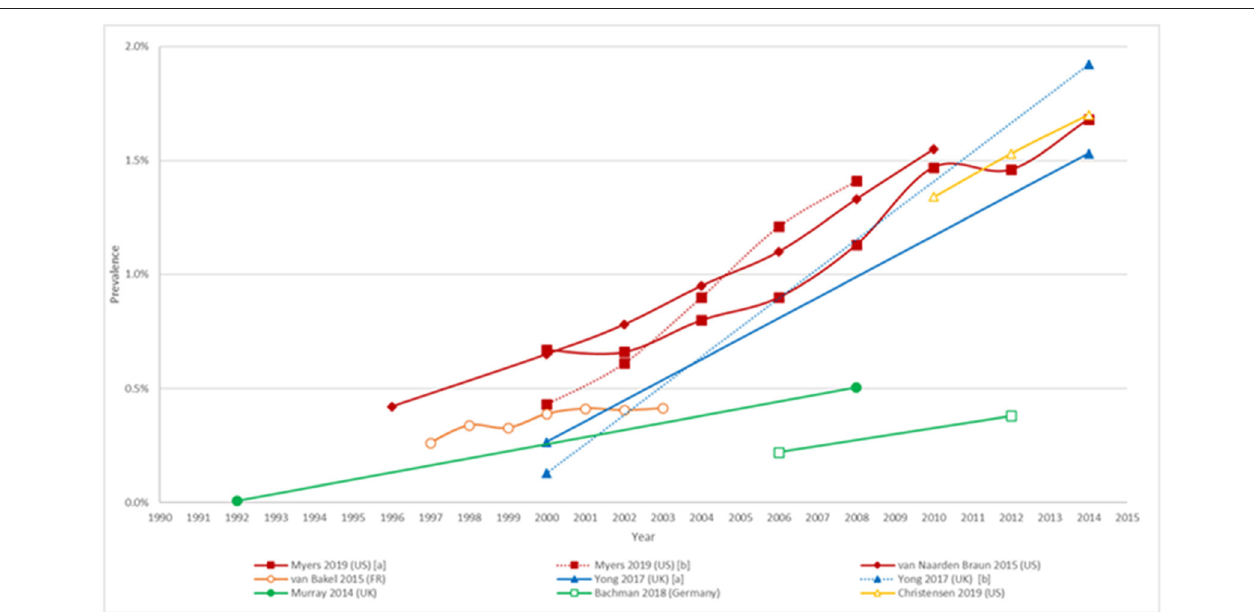
FIGURE 1 | Trends in prevalence of ASD. Myers et al. (21) [a] and [b] include the results from the CDC data set and clinically diagnosed data set, respectively; Yong et al. ( 22) [a] and [b] include results for the age group 5 to 12 and 13 to 17, respectively. Age of the population considered: 4 year-olds: Christensen et al. (15); 7 year-olds: van Bakel (23); 8 year-olds: Myers et al. (21); van Naarden Braun (24); 5-17 year-olds: Yong et al. (22); 0-24 year-olds: Murray (25), Bachman et al.